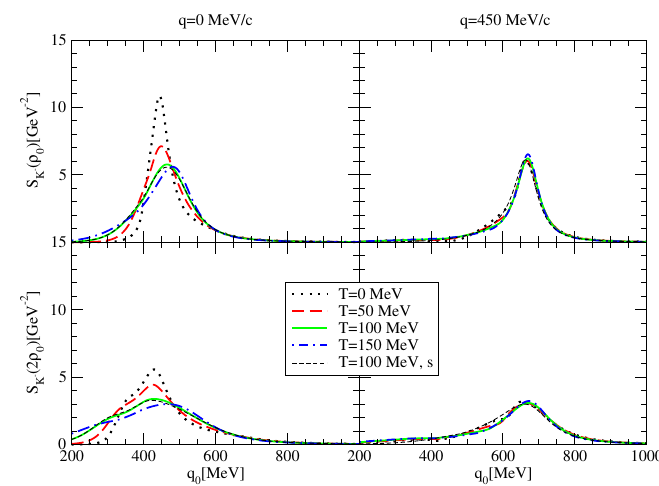
Figure 1. ¯ K spectral function for di ff erent momenta, densities and temperatures from the chiral model of Ref.